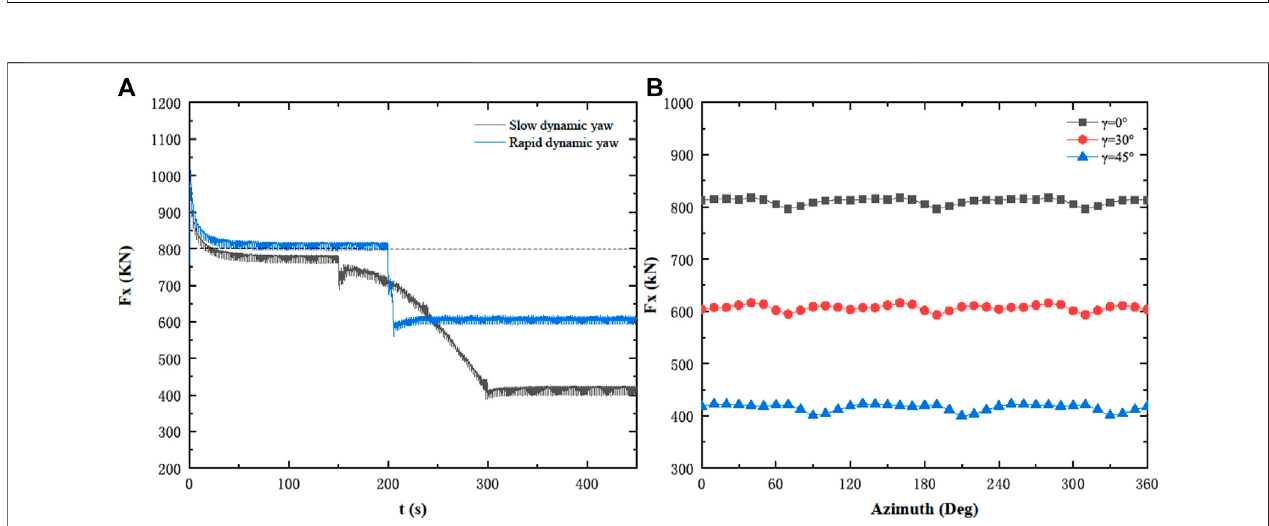
FIGURE 15 | Evolution of aerodynamic thrust: (A) thrust over simulation time; (B) in the last simulated rotation (At 0+ azimuth, Blade 1 points vertically up).